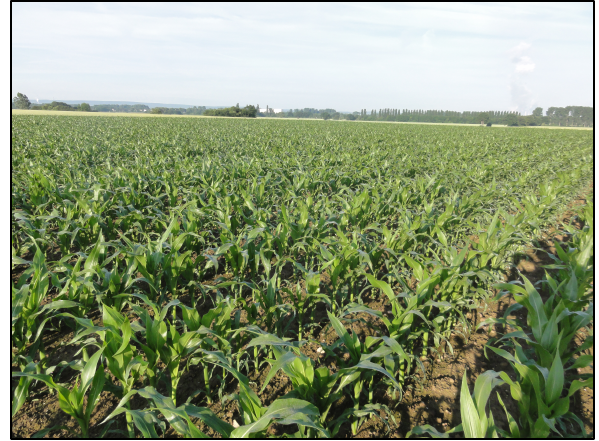
Figure 3. Southwest looking photo of the maize field on July 2 nd , shortly before the 2 nd WorldView-2 acquisition